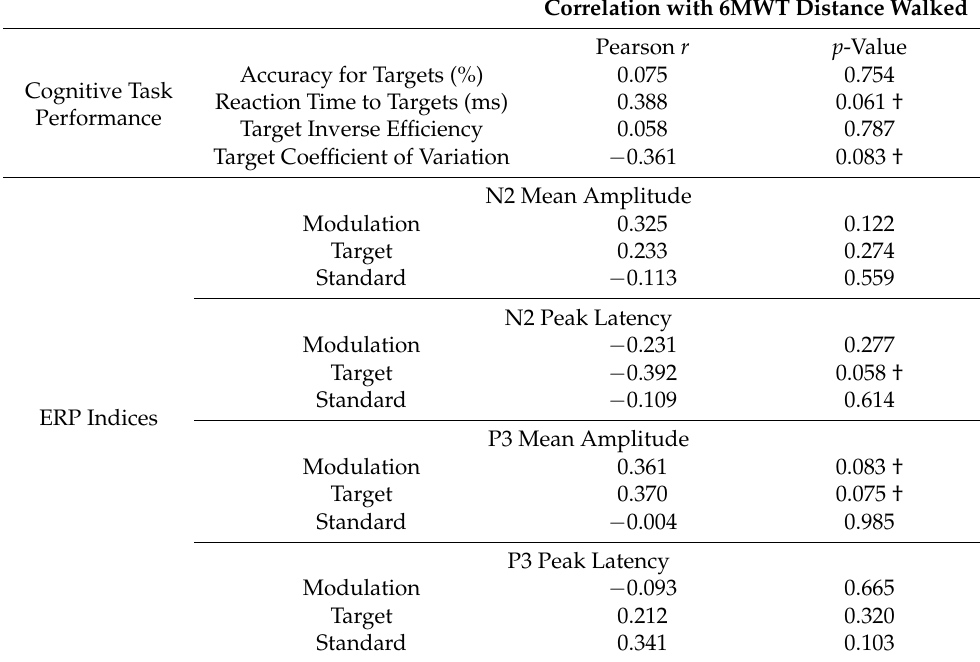
Table 4. Subsample partial correlation table examining auditory oddball, controlling for the variance of age and